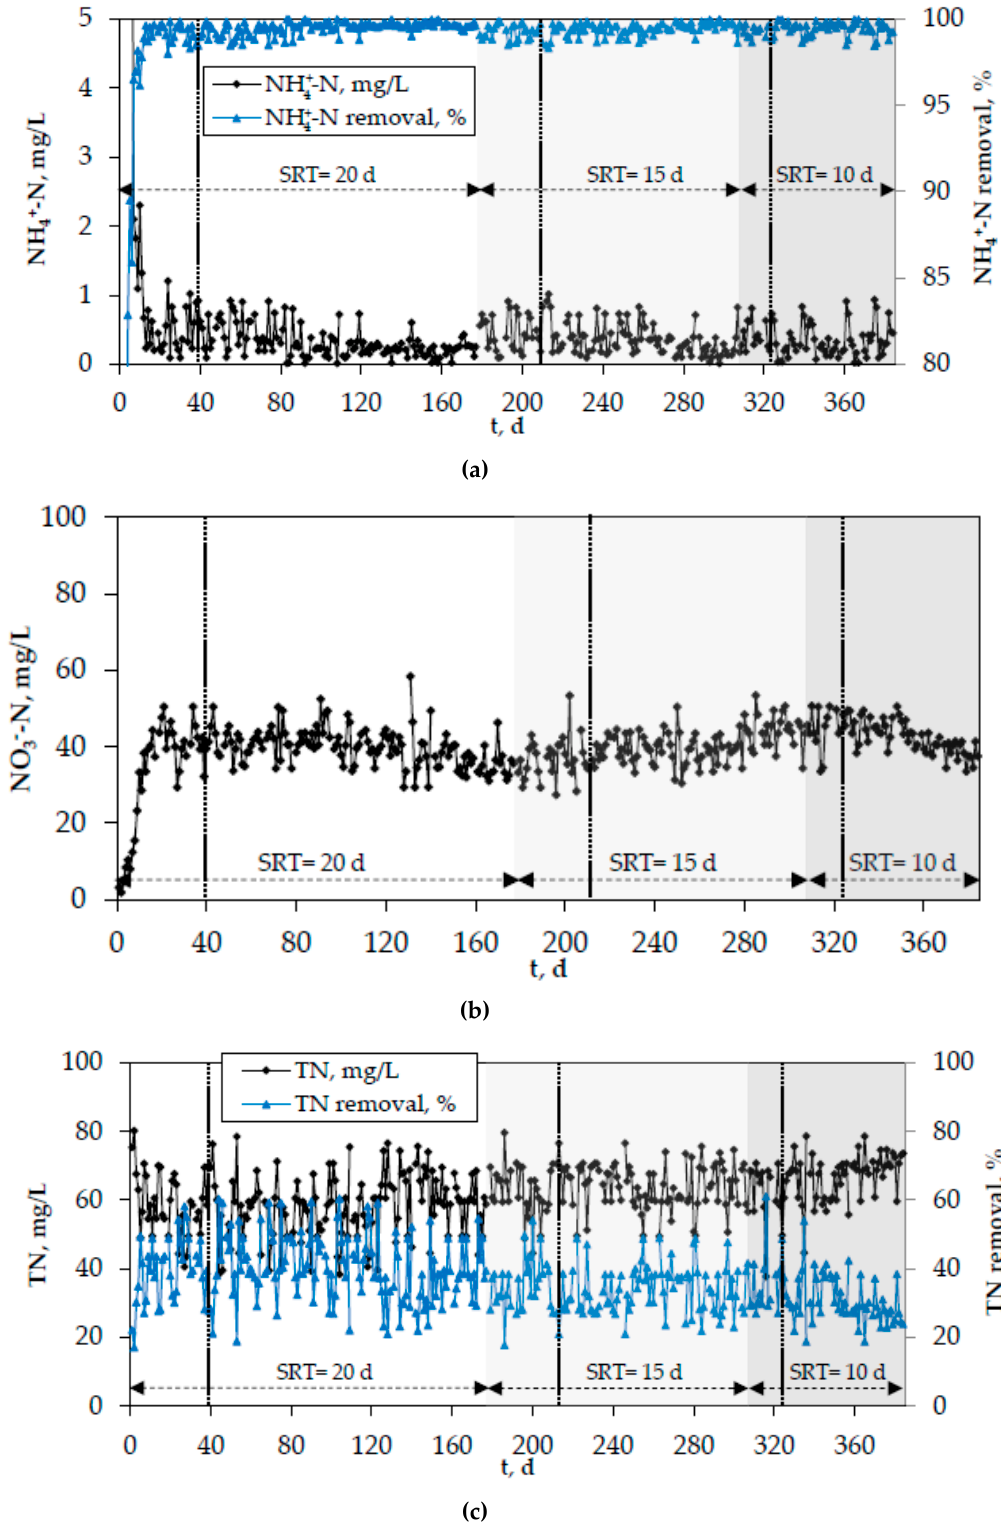
Figure 9. Evolution of ( a ) NH 4 + -N, ( b ) NO 3 − -N, and ( c ) total nitrogen (TN) in the e ffl uent of the lab-scale MBR and the respective removal rates.